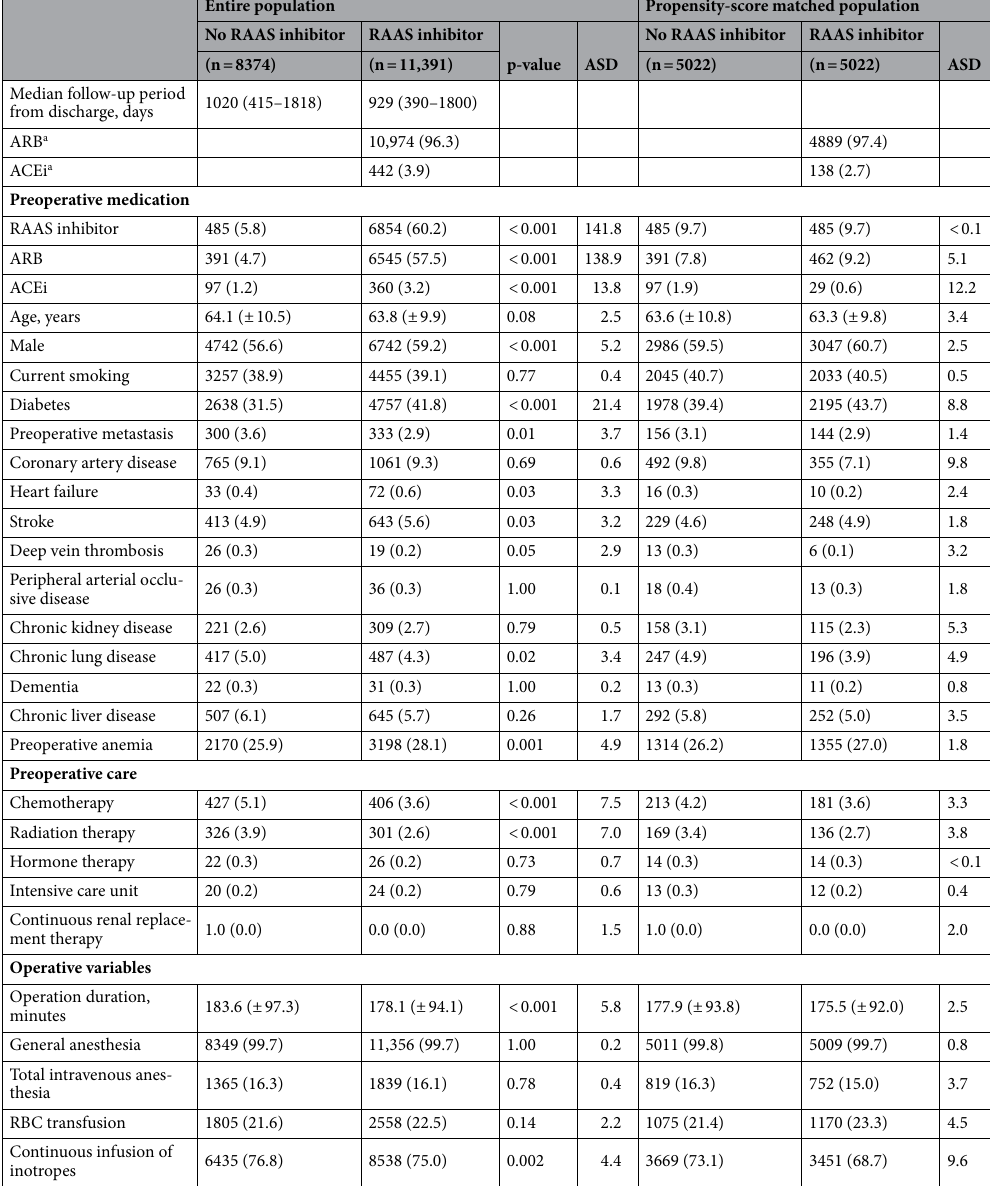
system, ARB angiotensin II receptor blockers, ACEi angiotensin-converting-enzyme inhibitors, ASD absolute standardized mean difference, RBC red blood cell. a These variables were not retained in the propensity-score